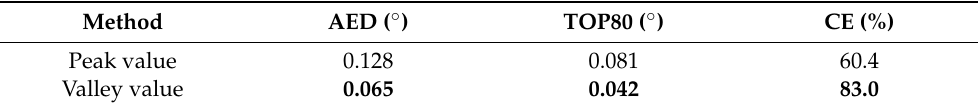
Table 3. Comparative experimental results of peak and valley values.